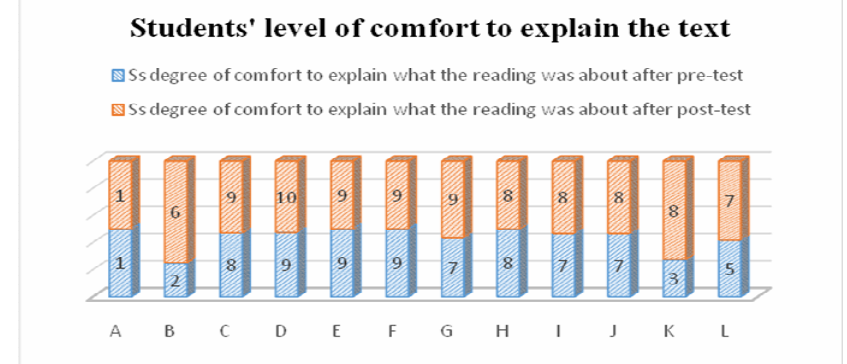
Figure 1. Students’(Ss) perception on how comfortable they would feel about explaining what the reading is about